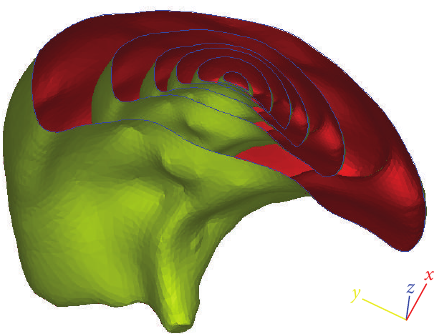
Figure 3: Section view of the multilayer grid structure.